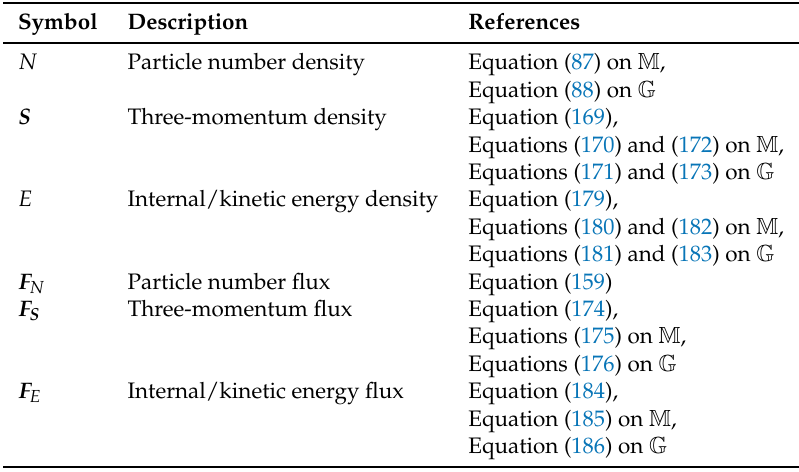
Table 4. Densities and fluxes measured in the fiducial frame (cid:79) in terms of the fluid three-velocity V measured by (cid:79) and quantities determined by thermodynamics and constitutive relations in the comoving frame ˜ (cid:79)